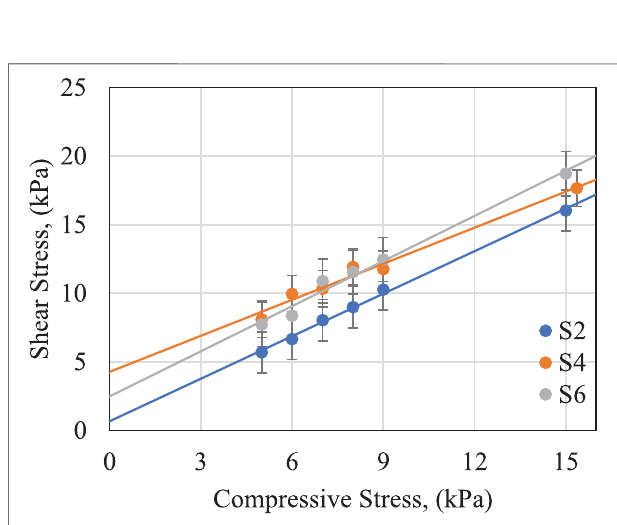
FIGURE5| Measuredshearandnormalstressforthethreecomparative loblolly pine samples.